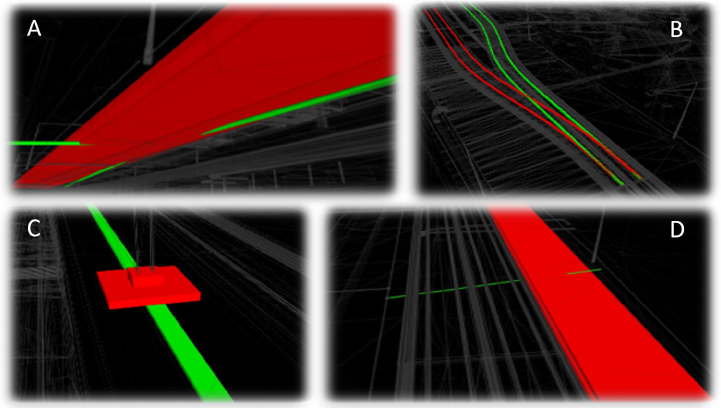
Figure 14. Examples of clashes found in the case study. In A and D there is the tram substructure and underground services; in B there is the armament i.e the heart and frame of the switches needles; in C there is the foundation plinth of the bus shelter and underground services.